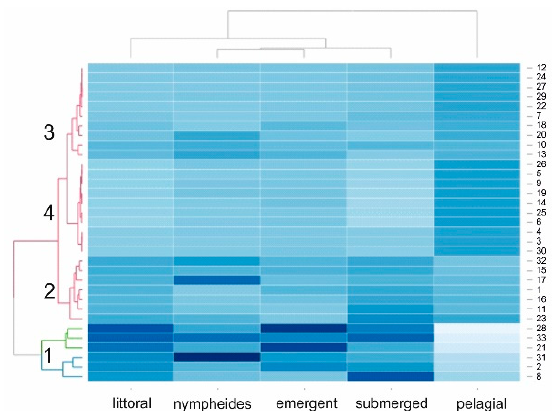
Figure 2. Correlation between studied lakes with regard to the macrophyte share (heat map) with presentation of a hierarchical tree plot to show the four groups of lakes characterized by a high similarity of species cover. The range of blue colors indicate the cover of macrophytes from light blue corresponding to the lack of macrophytes or their lowest cover to dark blue corresponding to their highest abundance. Names of lakes are shown in Table S1.